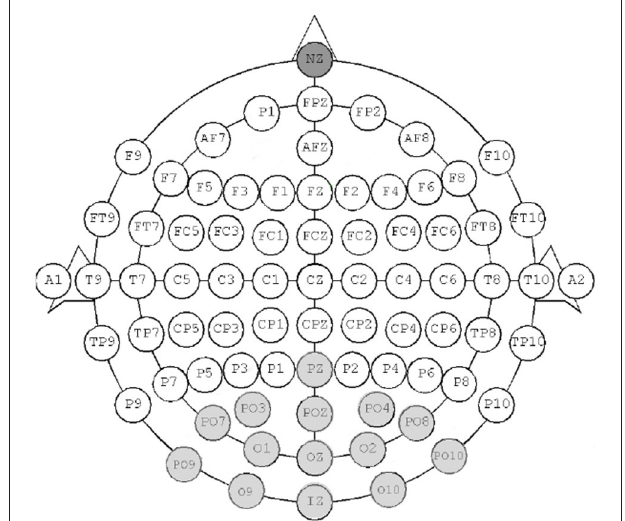
FIGURE 2 | An illustration of the functioning of the BCI system and the classifier. FIGURE 3 | The electrode placements for conceptual imagery used for